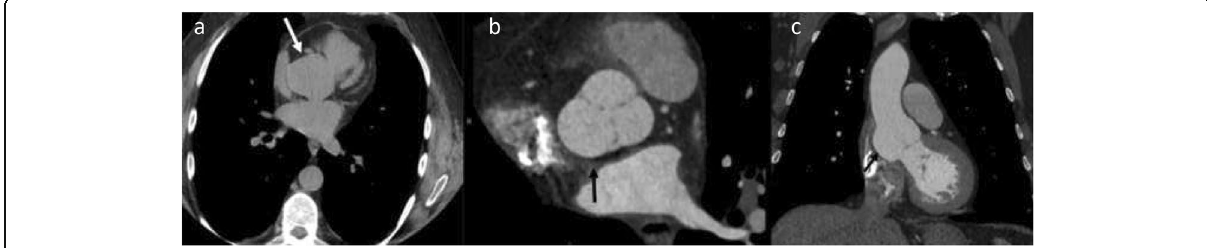
Fig. 6 A 41-year-old-man with incidentally detected sinus of Valsalva aneurysm. Non-contrast chest CT ( a ) obtained as a work-up for fever showed an incidental dilatation (white arrow) of the aortic root (CT was done with high pitch, enabling the anatomic evaluation of aortic root despite the lack of ECG gating). Follow-up contrast-enhanced-gated CTA images ( b and c ) showing an incidental aneurysm of the noncoronary sinus of Valsalva (black